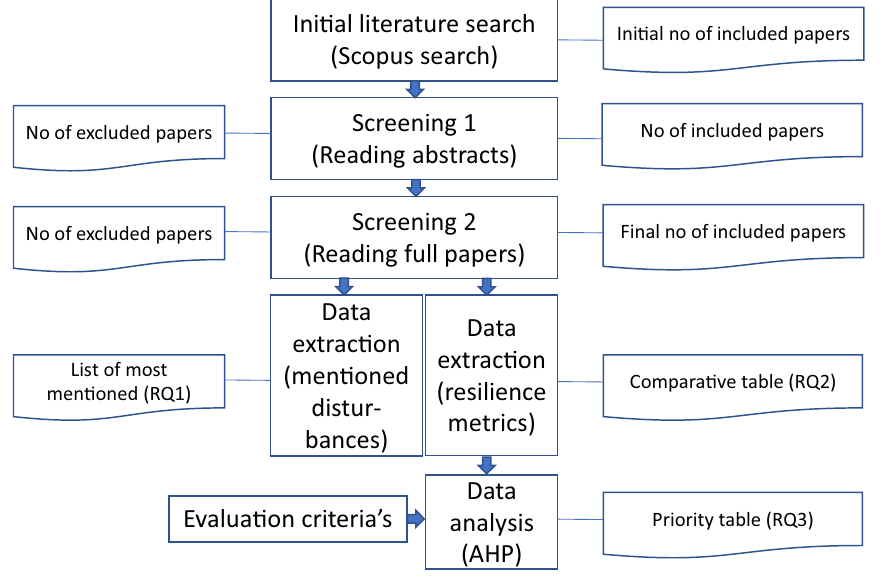
Figure 3. Main methodology of the